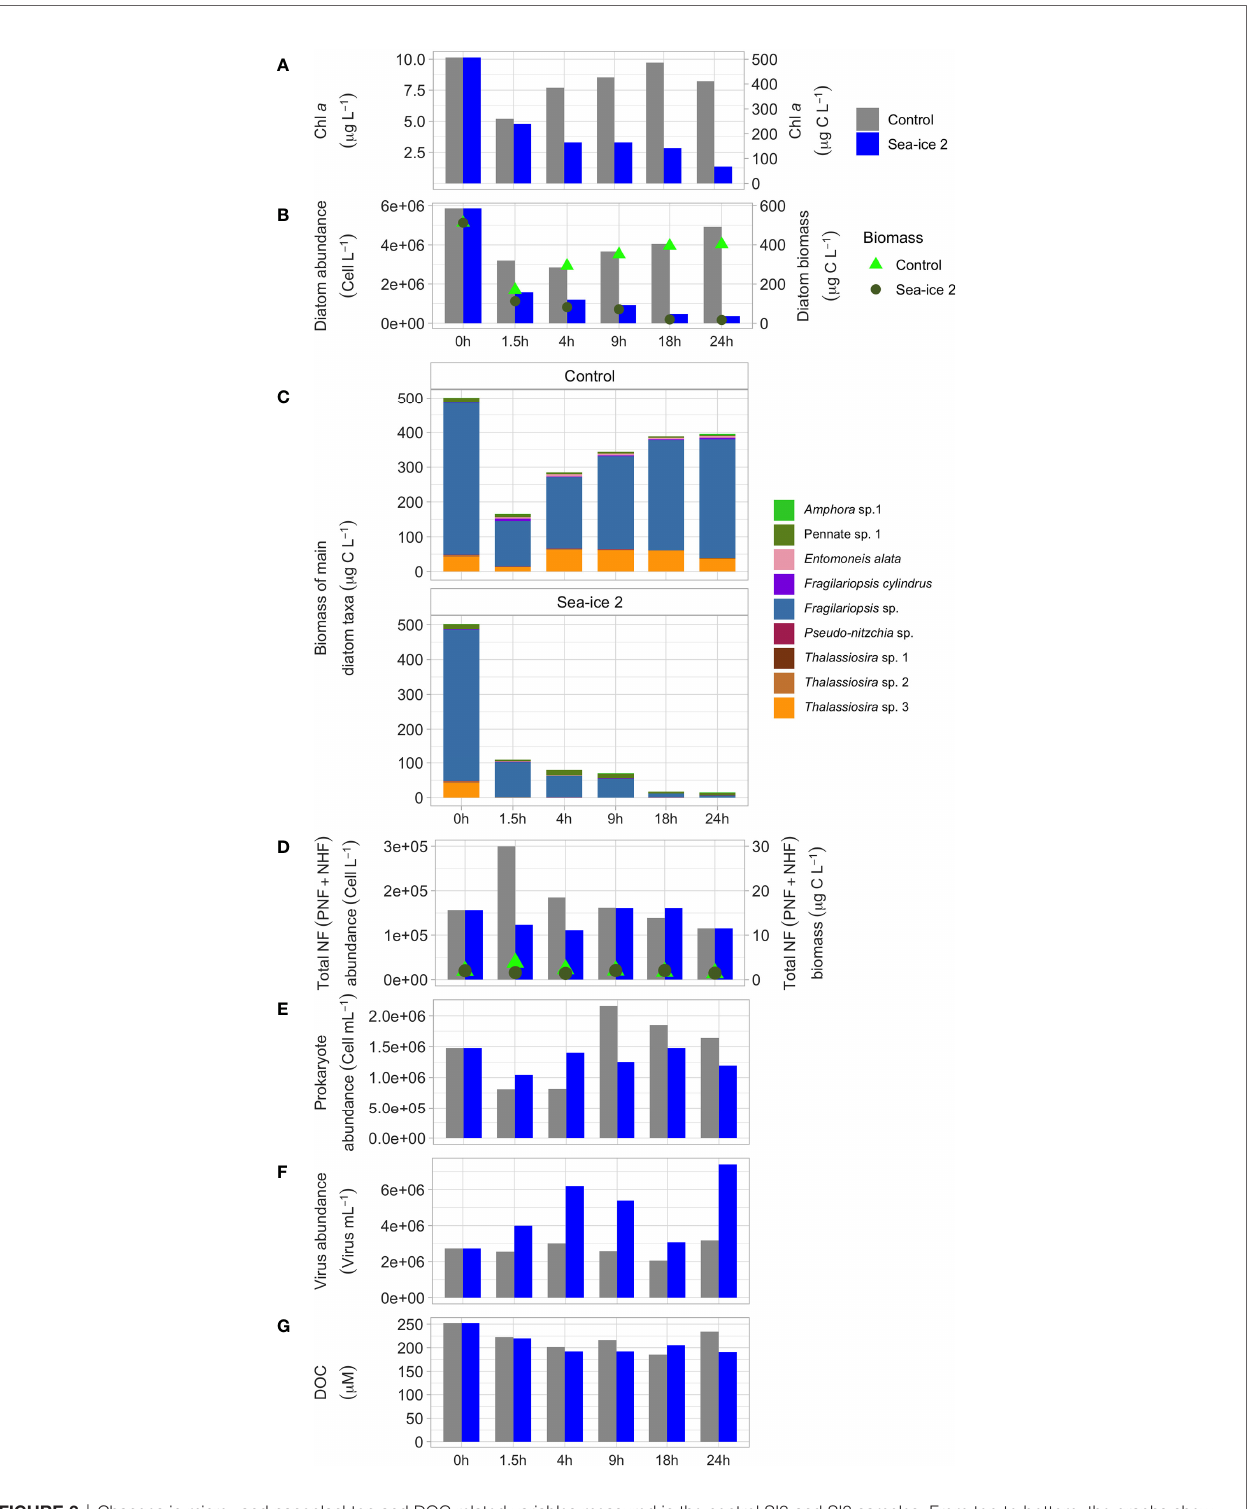
FIGURE 3 | Changes in micro- and nanoplankton and DOC related variables measured in the control SI2 and SI2 samples. From top to bottom, the graphs show (A) Chl a concentration; (B) diatom cell abundance (bars) and the corresponding carbon contribution (biomass, green dots); (C) biomass of the main diatom taxa; (D) abundances (bars) and biomass (green dots) of nano fl agellates (NF) including the sum of PNF and HNF; (E) prokaryote abundance; (F) viruses abundances; (G) DOC